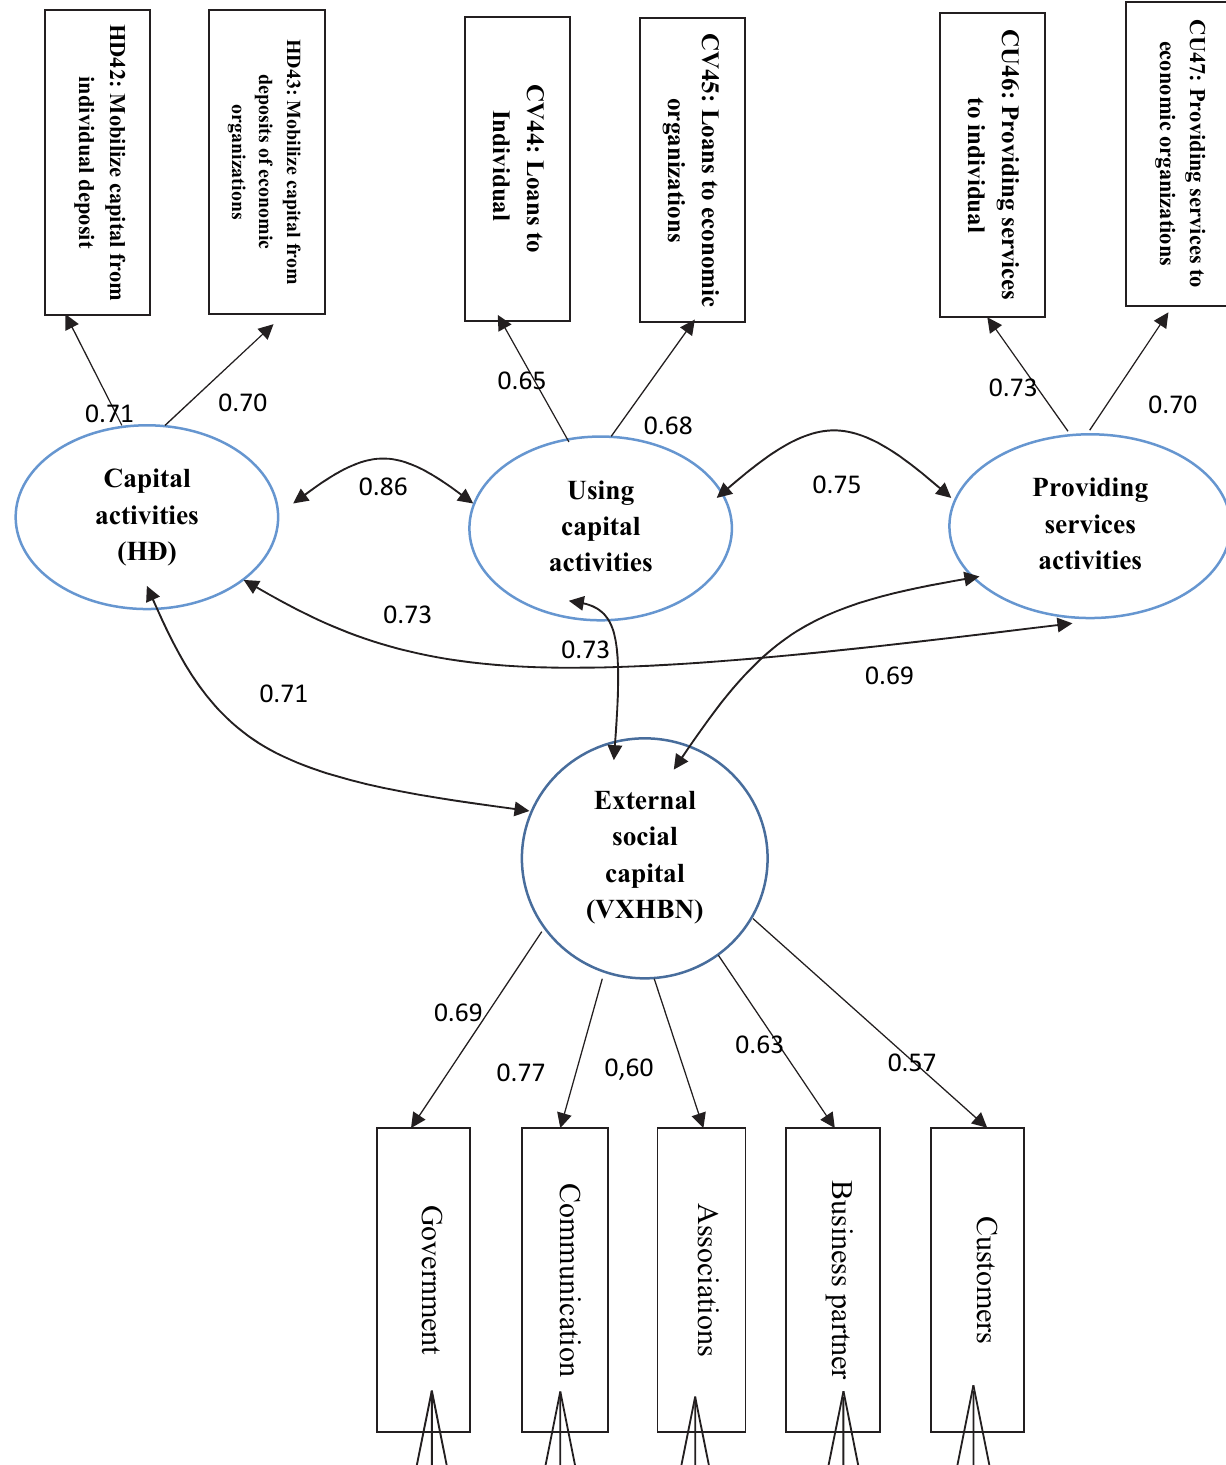
Fig. 1. CFA (standardized) between concepts in the research model Source: Estimated results from author's survey